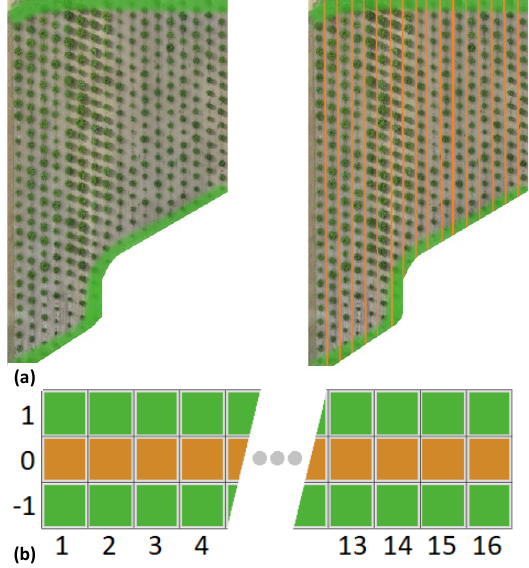
Figure 9. Path planning of UGV tracks in the orchard: ( a ) green lines indicate the field’s headlines and orange lines indicate the intermediate points between headlines; and ( b ) topological grid.